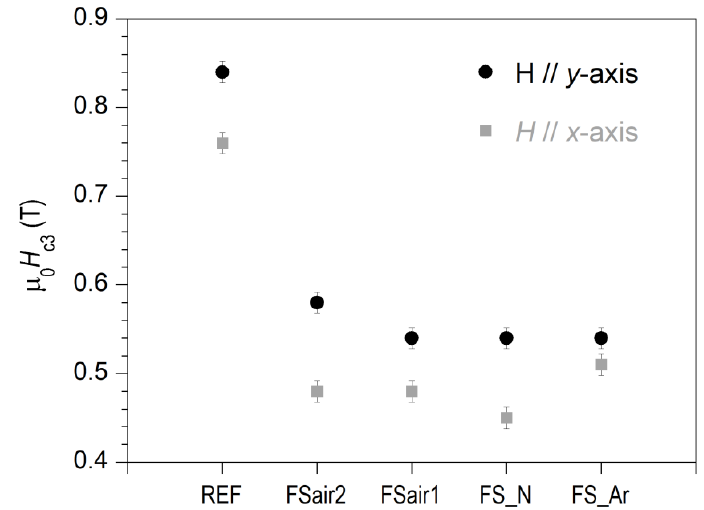
Figure 9. Critical surface fields, μ 0 H c3 , of all analyzed samples derived from χ ’’( H ) measurements at T = 5 K, f = 10 Hz and μ 0 h 0 = 10 μT, with the external magnetic field applied parallel to the x - and y - axes.